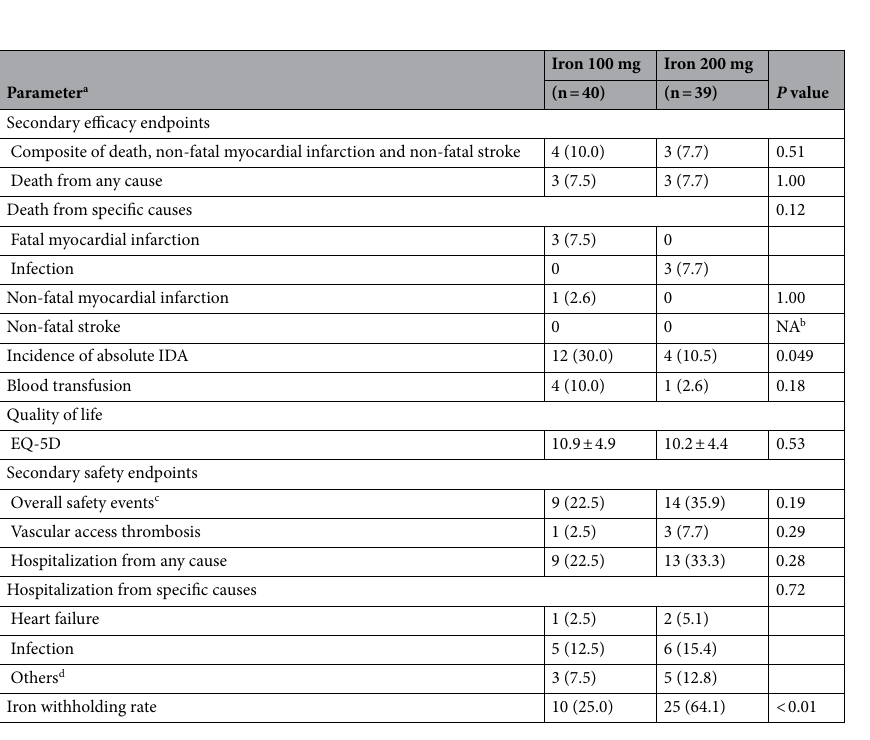
Table 2. Secondary efficacy and safety endpoints at month 12. ESA, erythropoiesis-stimulating agent; IDA, iron deficiency anemia; NA, not applicable. a Data are presented as mean ± standard deviation for continuous variables and number (percent) for categorical variables. Percentages may not total 100 due to rounding. b If zero cell is presented, P value cannot be calculated and is denoted as not applicable. c Overall safety events compose of vascular thrombosis and hospitalization from any cause. d Others are parathyroidectomy and